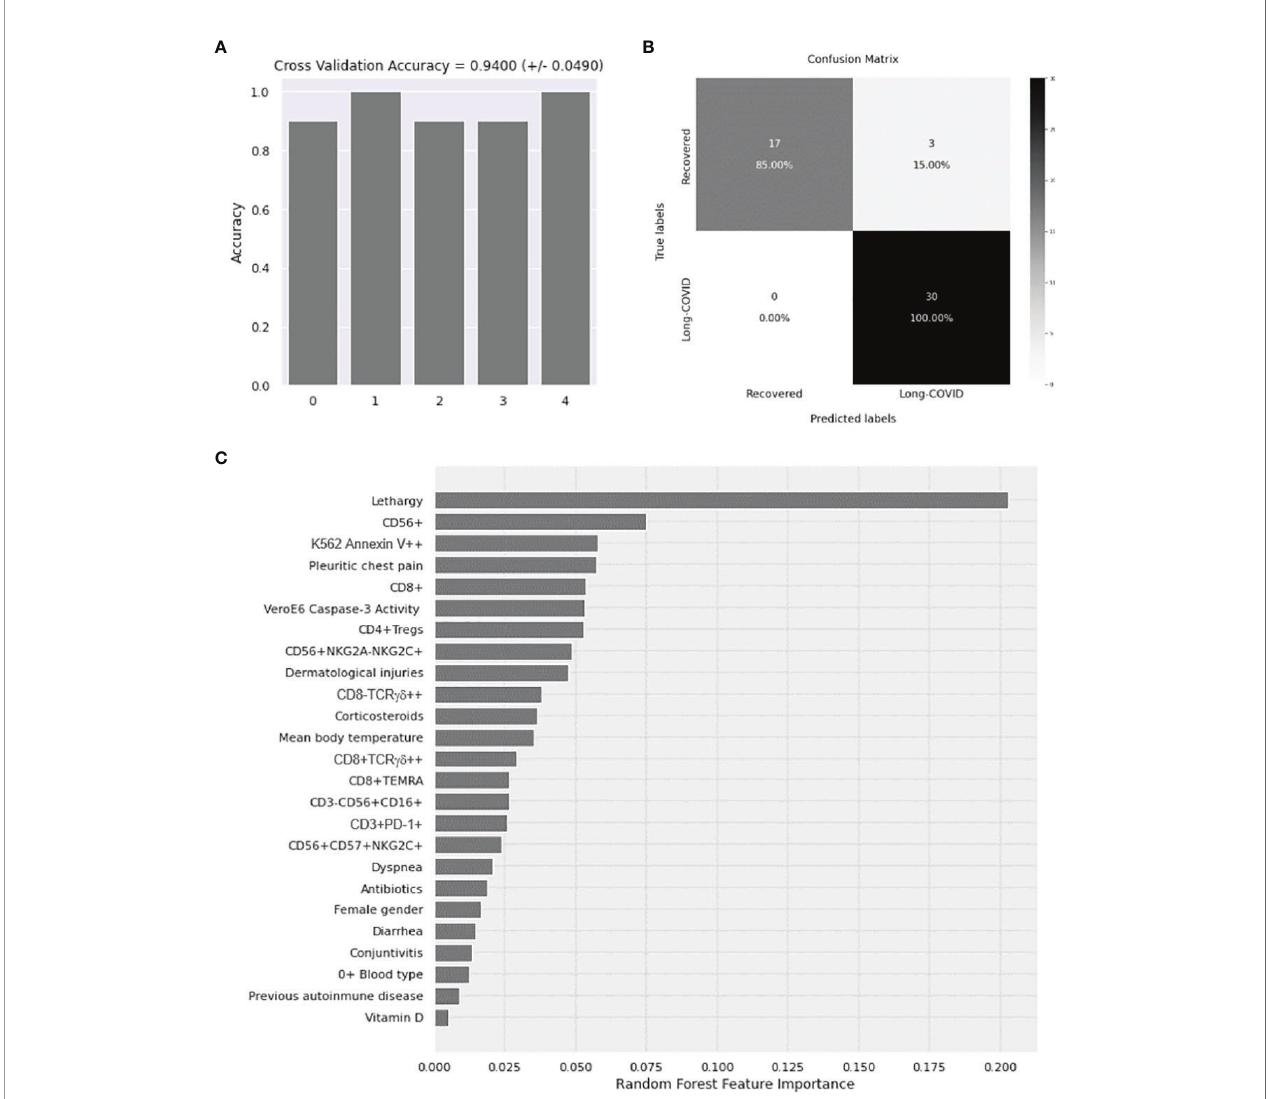
FIGURE 6 | Application of Random Forest algorithm and Gini VIM method for the evaluation of the importance of demographic, clinical, and immunological parameters with statistical signi fi cance as diagnostic biomarkers for Long-COVID. (A) Calculation of the accuracy for 5 iterations of the outer loop of the nested K- fold cross validation. (B) Confusion matrix confronting the conditions predicted by the algorithm and the true conditions for the correct assignment of the participants to the Long-COVID group or the Recovered group. (C) Classi fi cation of the demographic, clinical, and immunological features with statistical signi fi cance according to their importance to predict the correct classi fi cation of the individuals to the Long-COVID group or the Recovered group. VIM, Variable Importance